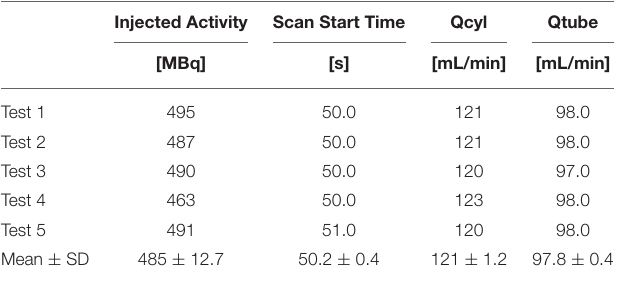
TABLE 1 | Scan parameters for all repeated scans. Injected